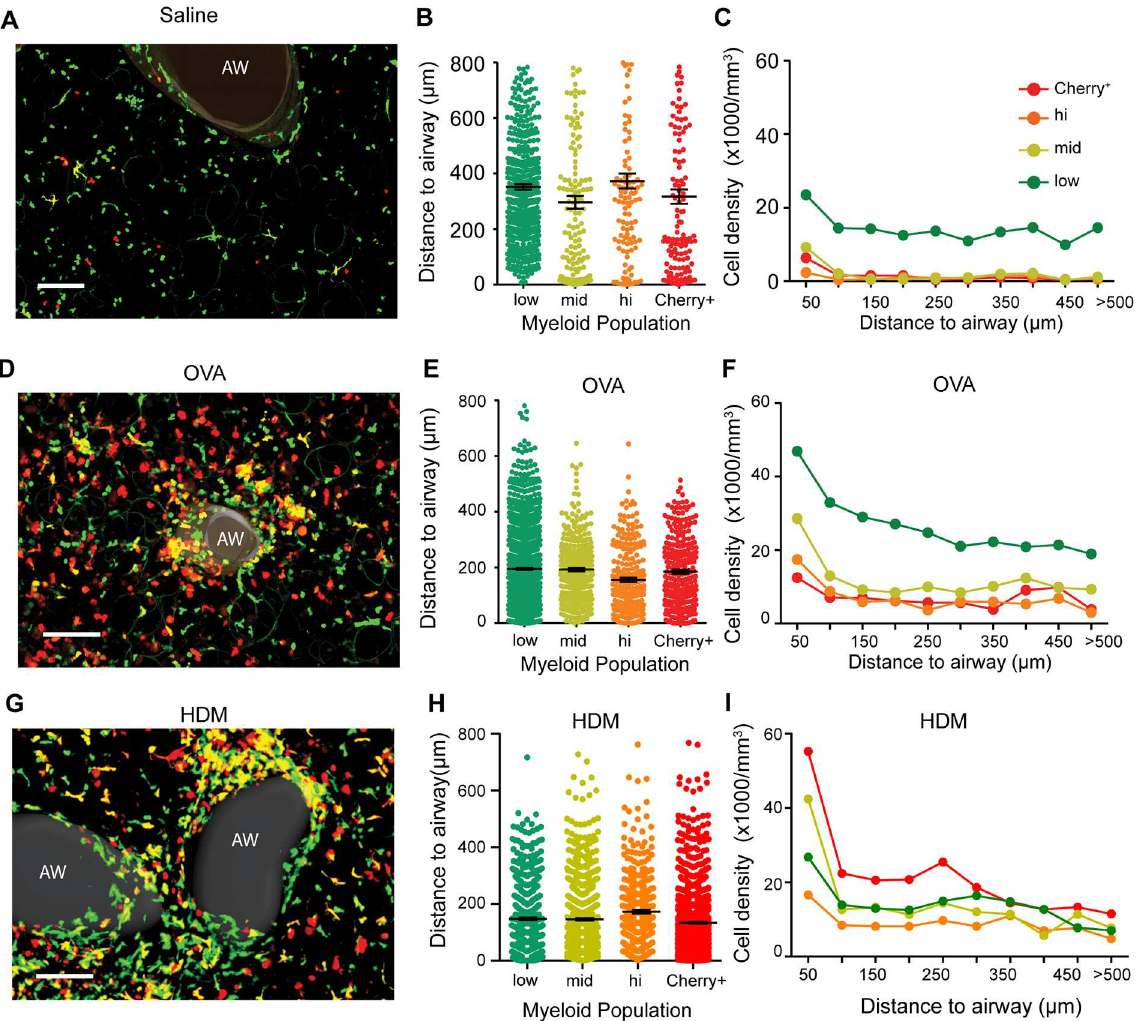
Fig 2. Airway-proximal accumulation of myeloid populations in inflamed mouse lungs. Mouse lungs were sectioned and analyzedusing the color labelingstrategy defined in Fig 1. Bins were set similarly to flow, using the transformation shown in S3 Fig. ( A,D,G ) Two-photon micrographs of control (A) Ova- (D) or HDM (G) treated lungs from Cx3cr1 -eGFP x Cd11c- mCherry mice. Scale bar = 100 μ m. ‘AW’ = airway. ( B,E,H ) Distances of myeloid cells from nearest airway epitheliumin control (B) ova- (E) or HDM (H) treated lungs. Myeloid populationswere categorized into divisionsbased on the imaging Cherry:GFP color scale, as described in S3 Fig. ( C,F,I ) Density of myeloid populationsin control (C) ova- (F) or HDM (I) treated lungs, as a function of distances from airways, using the identicalratio color scale as in panels B,E,H. See also Video 1. Data represent 4 independent experiments for each